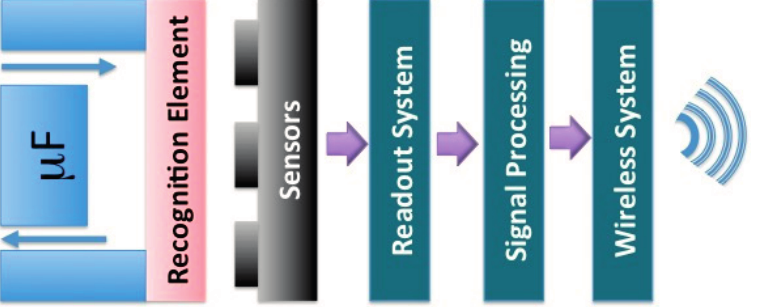
Figure 10. A simplified model of integrated biosensors including an interface circuit connected to front end devices (microelectrodes). These electrodes are coated with RE in order to transduce the biological activities to physical changes. The main building blocks are used in wearable, handheld and implantable biosensors, however the microfluidic ( μ F) structure is used in handheld POC